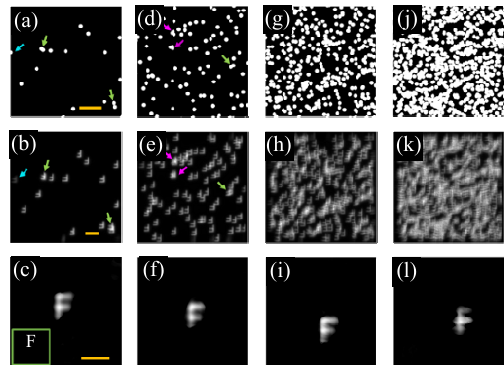
Fig. 2 Simulation of pinhole camera imaging through different amplitude pinhole screens. The first row is the simulated distributions of the pinholes on the screen, the second and thirds rows show the corresponding light patterns on the camera and reconstructed images, respectively. The number of pinholes gradually increases from column to column ( N =20, 100, 400, and 900). The scale bars of the three rows are 1 mm, 1 mm, and 0.5 mm, respectively. The inset in (c) is the photograph of the object, i.e., a hollowed letter F. The colored arrows in the first and second rows attract attentions to particular pinholes and their corresponding pinhole